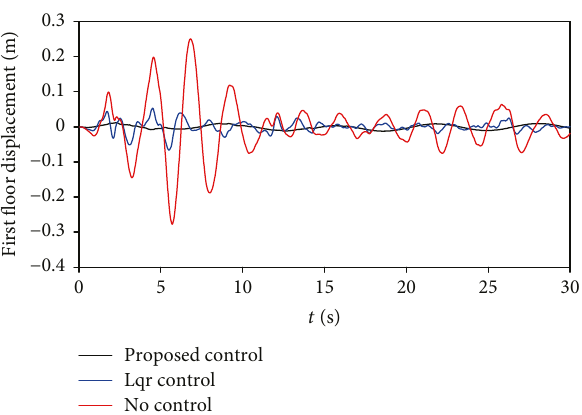
Figure 1: Displacement response example.